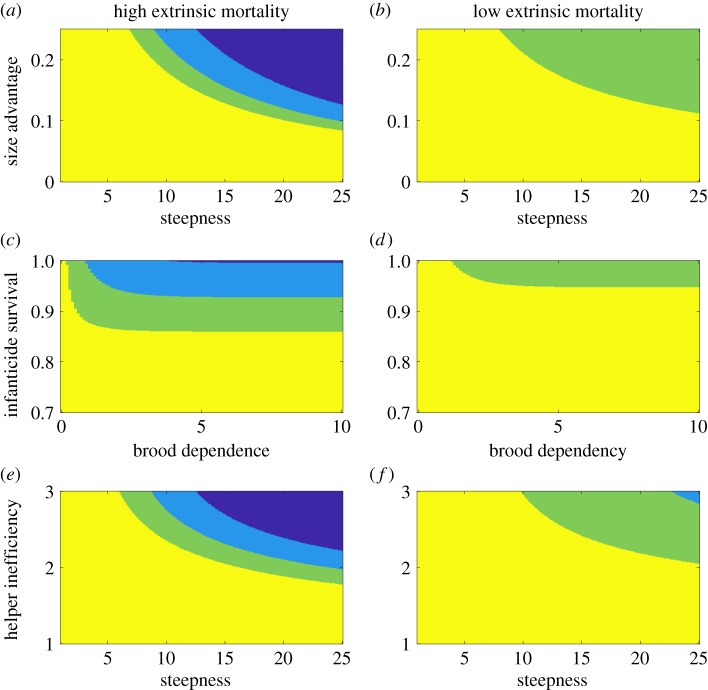
Effects of combinations of two parameters with external mortality (high and low) on the likelihood of within-group conflicts of interest. Area of parameter space where the interests of group members are aligned (yellow and dark blue area, denoted ‘no conflict’), where a conflict between BS and HSO occurs (light blue), and where a conflict between BS and HO occurs (green and light blue). Yellow area is where becoming involved in a contest and defeating the intruder is favourable for all group members; dark blue area is where not becoming involved in a contest and the intruder replaces BS is favourable for all group members. (a,b) Intruder's size advantage sI versus steepness of threshold curve k1; (c,d) infanticide survival 1 − μ versus duration of brood dependence k3; (e,f), helper inefficiency k2 versus steepness of threshold curve k1. Fixed parameters are: sI = 0.13, μ = 0.05, k1 = 20, k2 = 2, k3 = 10, (a,c,e) psurv = 0.4 and (b,d,f) psurv = 0.8. (Online version in colour.)